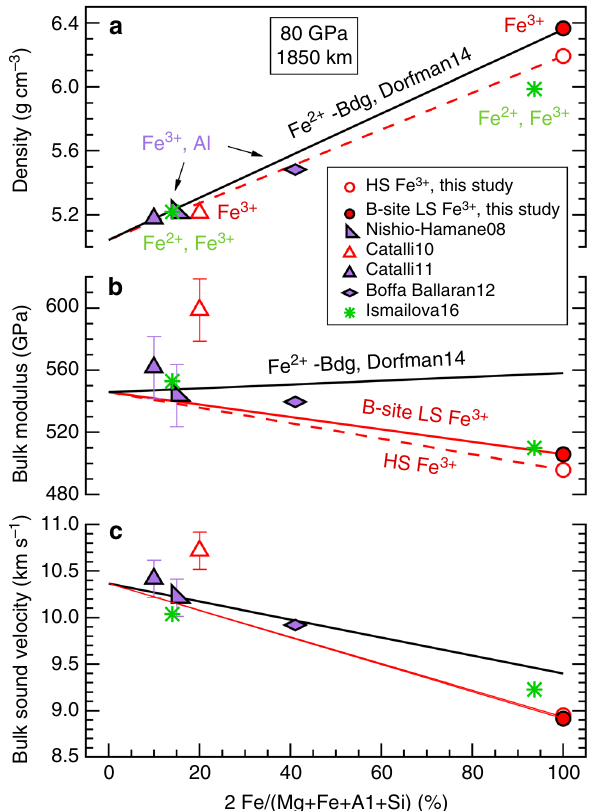
Fig. 4 Variation of observable seismic properties of bridgmanite as a function of iron content at 80 GPa and 300 K. EoS results from this study and previous work summarized in ref. 19 demonstrate that a density b bulk modulus, and c bulk sound velocity exhibit different dependence on Fe 2 + and Fe 3 + content. The red solid lines are linear interpolations between MgSiO 3 -Bdg and end members for high-spin (HS) Fe 3 + -Bdg and the red dashed lines are those for B-site low-spin (LS) Fe 3 + Bdg. The black lines are linear fi ts for Fe 2 + -Bdg summarized in ref. 19 . The Fe 3 + -Bdg end member is from this study, and the open and solid circles are for HS and B-site LS Fe 3 + Bdg, respectively. Differences between 21 (red triangles) and solid red line trend for bulk modulus and sound velocity may be caused by compositional changes during Bdg synthesis from glass in the laser heated diamond anvil cell. The purple symbols are for Fe 3 + , Al-bearing Bdg samples 22,70 , and the green symbols are for Fe 3 + , Fe 2 + -bearing Bdg samples with Fe 3 + / Σ Fe